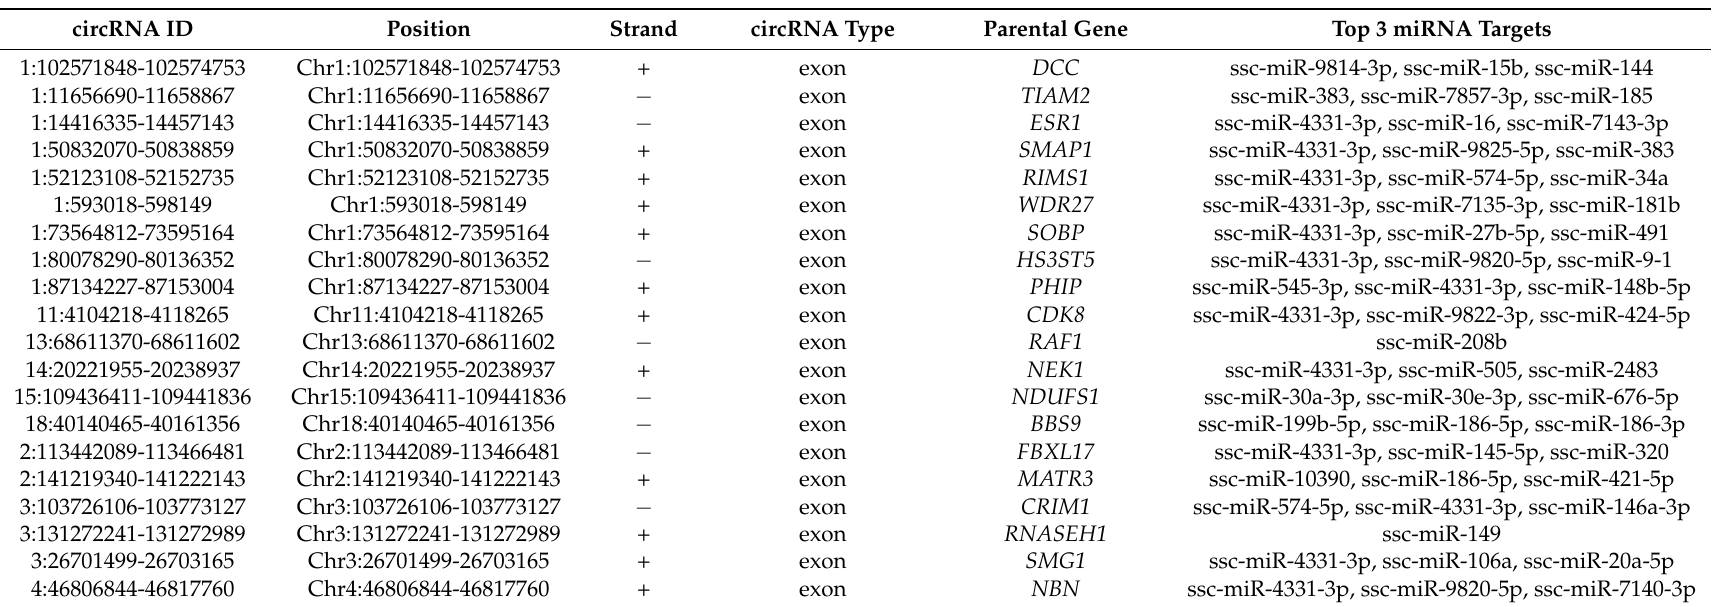
Table 1. The differentially regulated circRNAs in this study of hypothalamus of gilts. circRNA ID Position Strand circRNA Type Parental